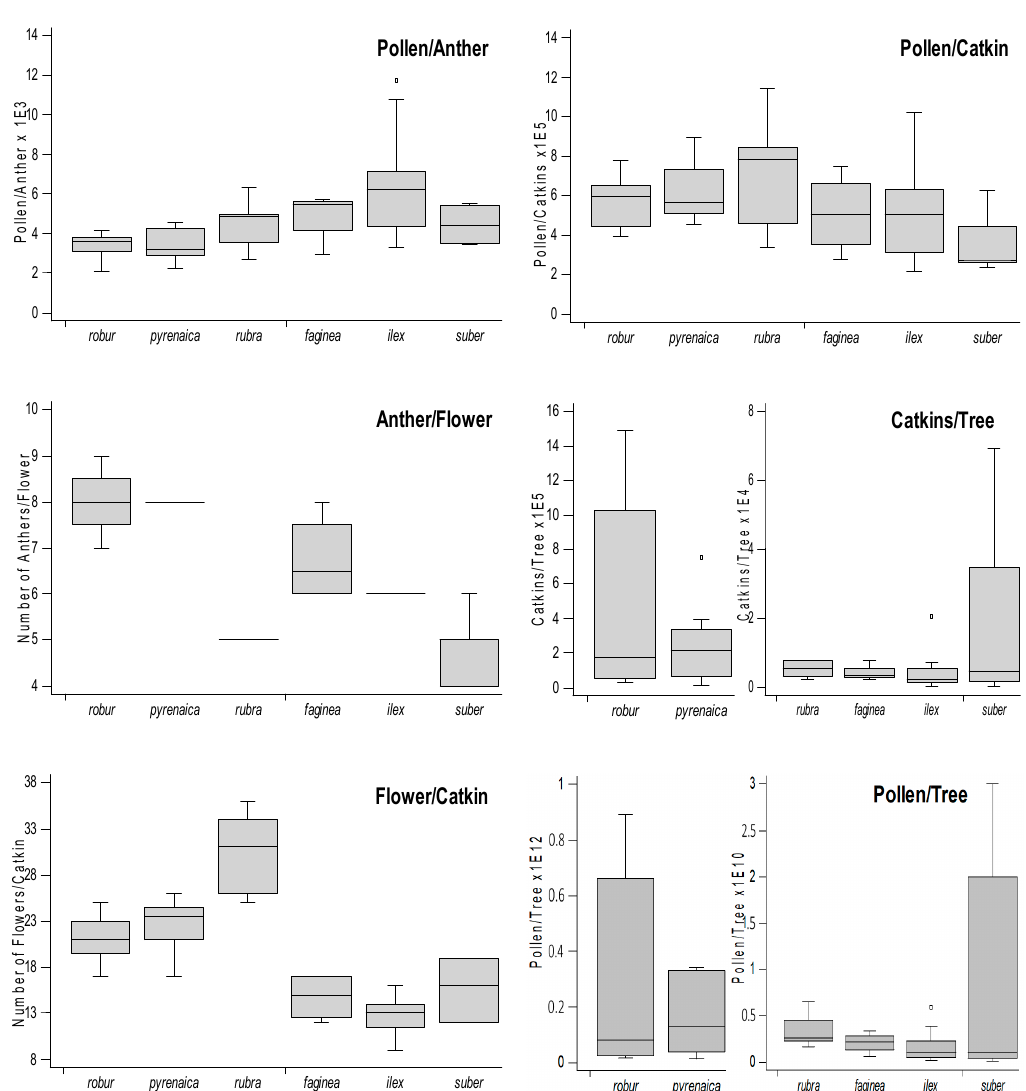
Figure 2. Box-plots of pollen per anther, anthers per flower, flowers per catkin, pollen per catkin, catkins per tree and pollen per tree of the studied Quercus species ( robur, pyrenaica, rubra, faginea, ilex and suber ). Median (black line), Box: 25%–75%, Non-outlier rang (Whisker) and outliers (point). Catkins per tree and pollen per tree plots of Q. robur and pyrenaica values were showed separately in order a better visibility of the scale.